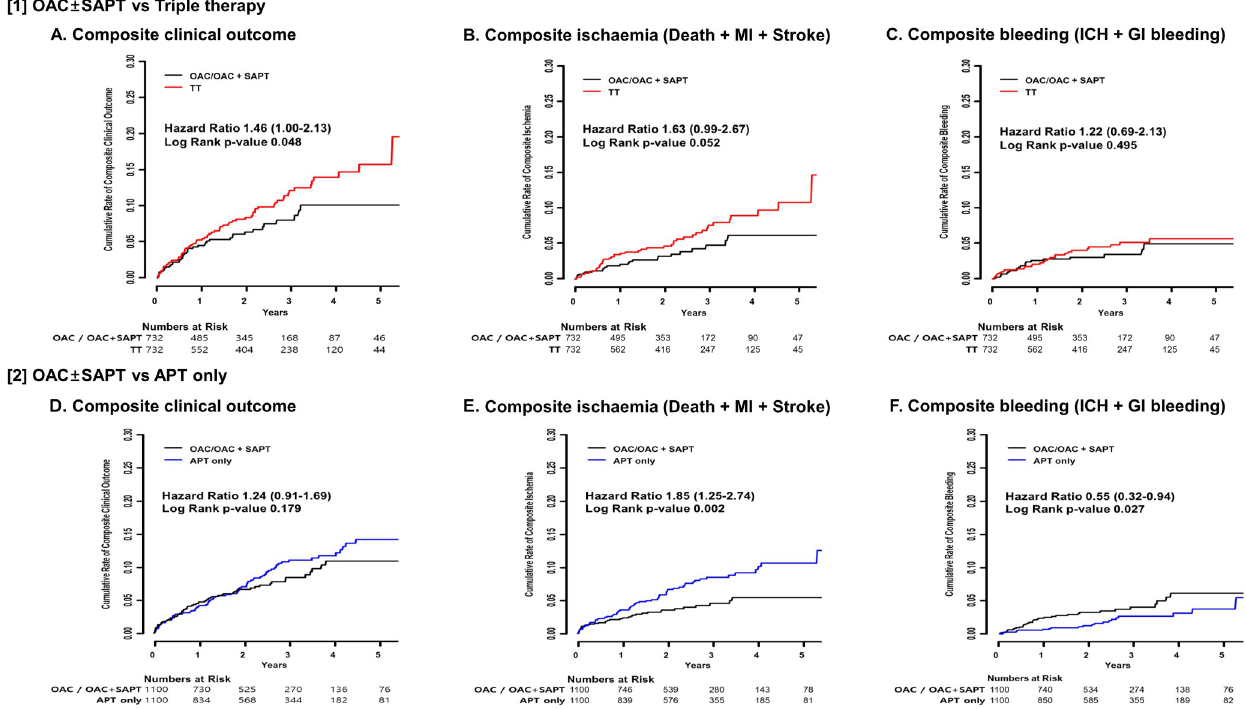
Fig 2. Ischaemic/bleeding risk in patients with AF according to antithrombotic therapy at 1 year after PCI. Cumulative risks for ischaemic, bleeding events, and composite outcome were assessed among patients with TT and APT only compared to those with OAC ± SAPT. AF = atrial fibrillation, APT = antiplatelets, GI = gastrointestinal, ICH = intracranial hemorrhage, MI = myocardial infarction, OAC = oral anticoagulants, PCI = percutaneous coronary intervention, SAPT = single antiplatelets, TT = triple therapy.